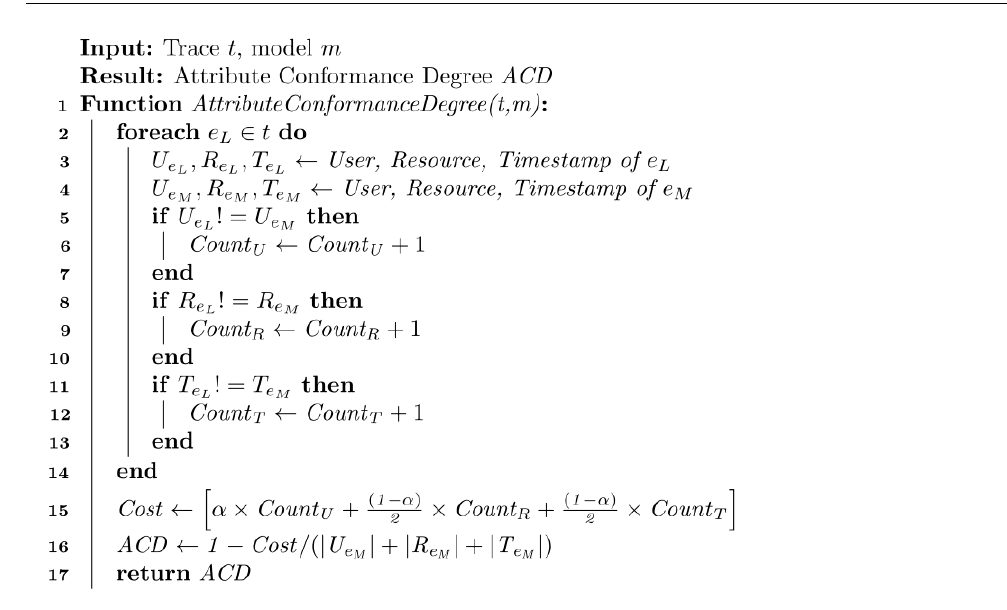
Algorithm 2: Calculation of Attribute Conformance